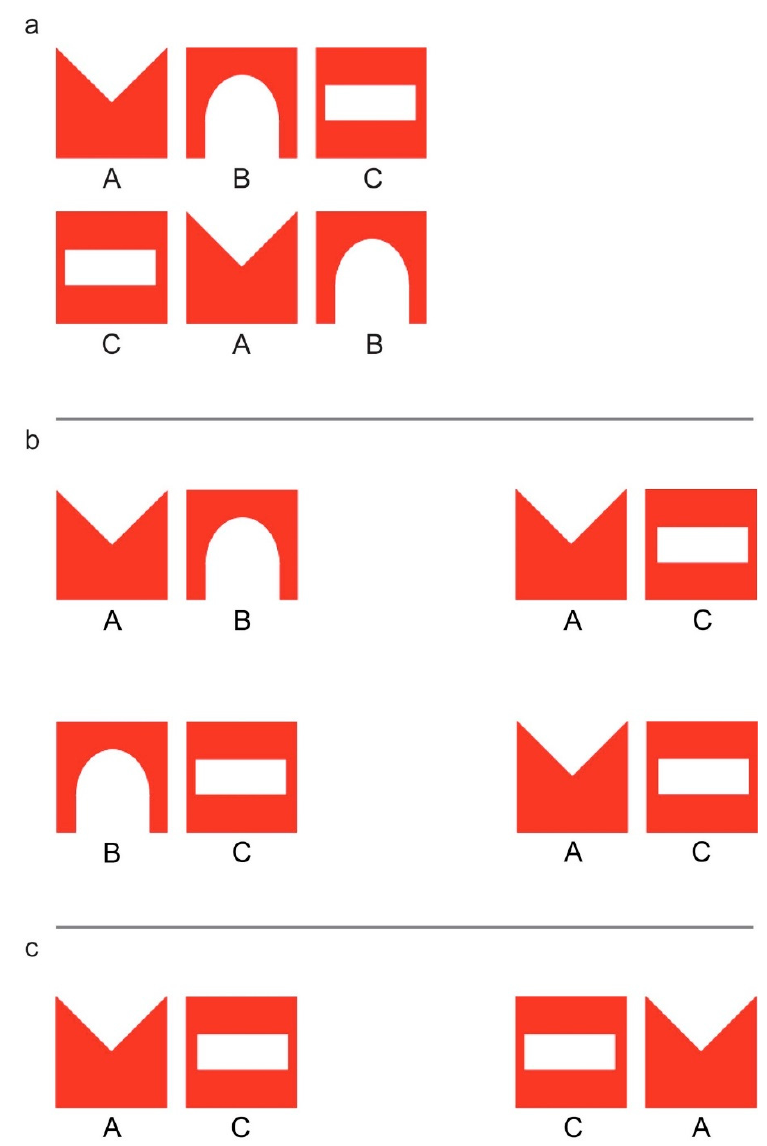
Figure 1. The triplets used as imprinting and test stimuli in Experiment (Exp.) 1, ABC and CAB. The triplet ABC was used as imprinting stimulus in Exp. 2 and 3 ( a ); the two pairs of fragments used as test stimuli in Exp. 2, AB vs. AC and BC vs. AC ( b ); the two fragments used as test stimuli in Exp. 3, AC vs. CA ( c ).